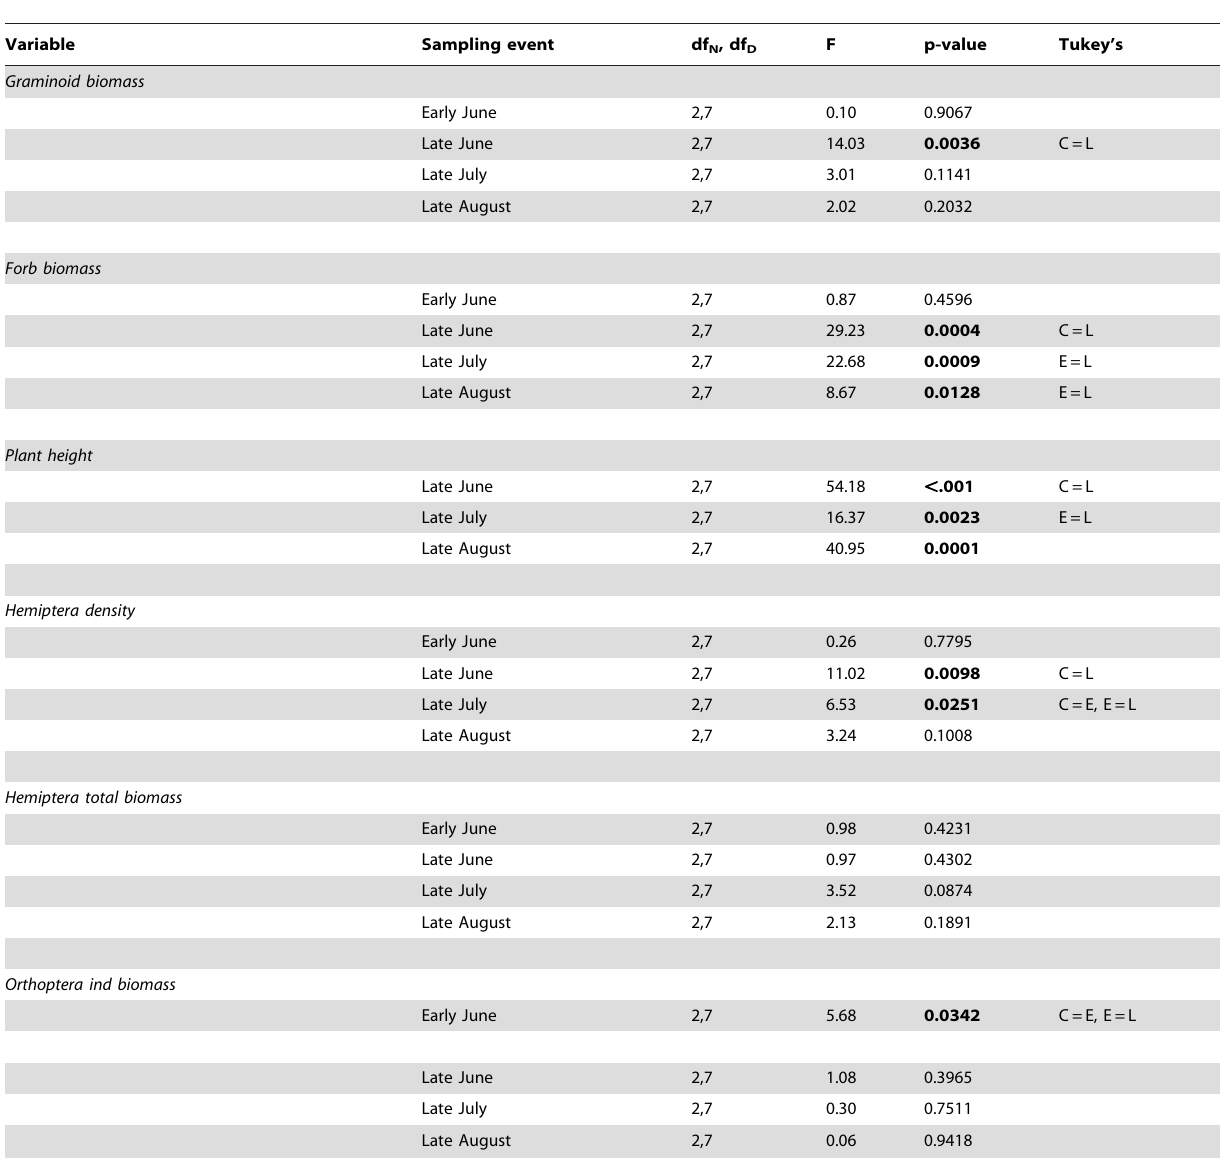
Table 2. Univariate one-way ANOVAs for each sampling event and Tukey’s Honestly Significant Difference multiple comparisons when a significant treatment effect was present within each sampling event for upland grasslands